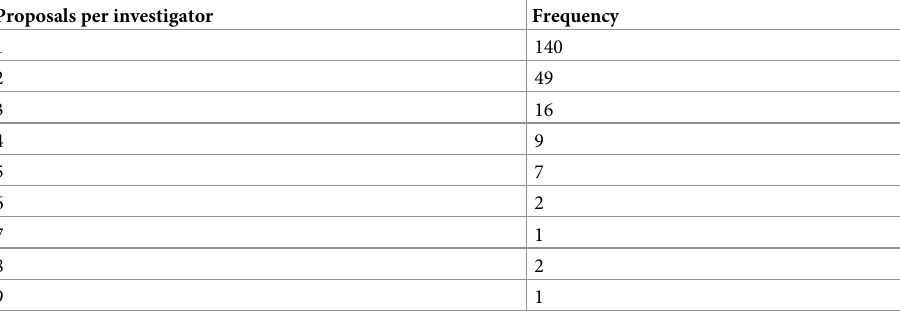
Table 1. Frequencies of proposals per